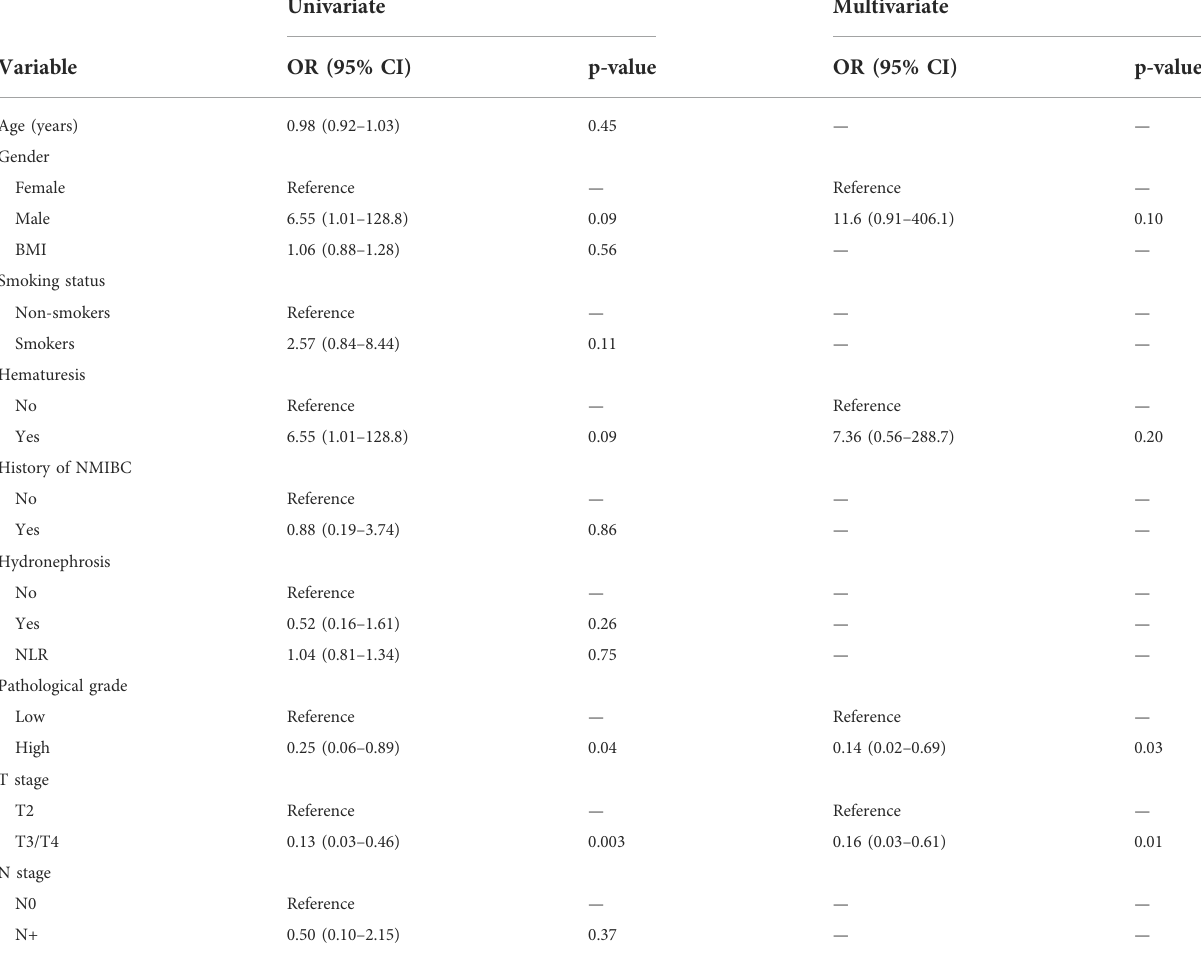
TABLE 2 Univariate and multivariate logistic analysis results of variables associated with neoadjuvant chemotherapy (NAC)